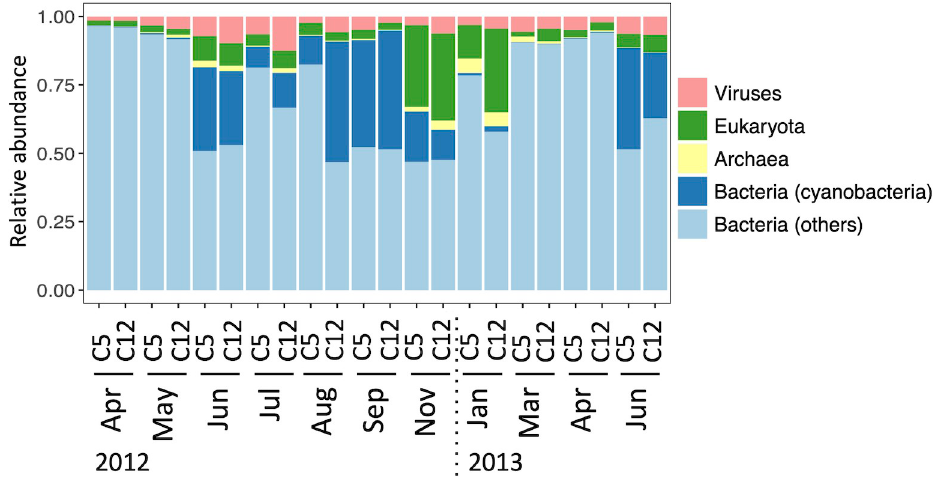
Fig 2. Domain rank composition of predicted peptide sequences. Cyanobacterial sequences are distinguished from other bacterial sequences.